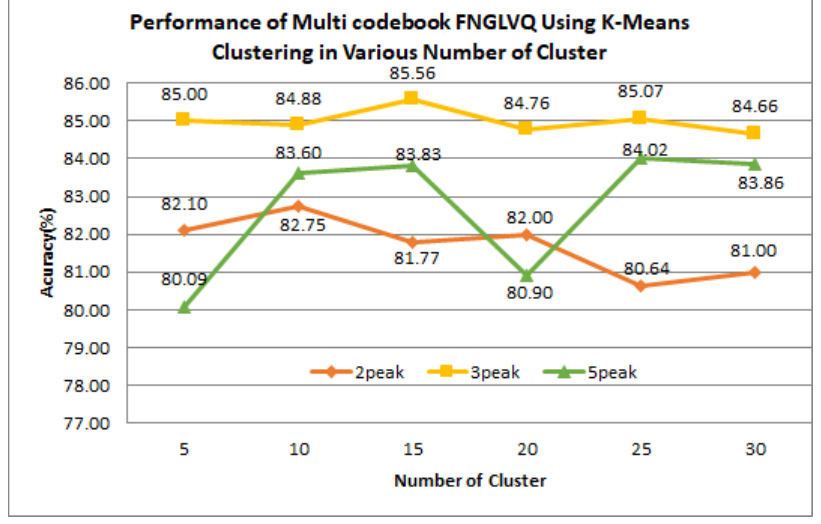
Figure 6. The impact of number of cluster on K-Means